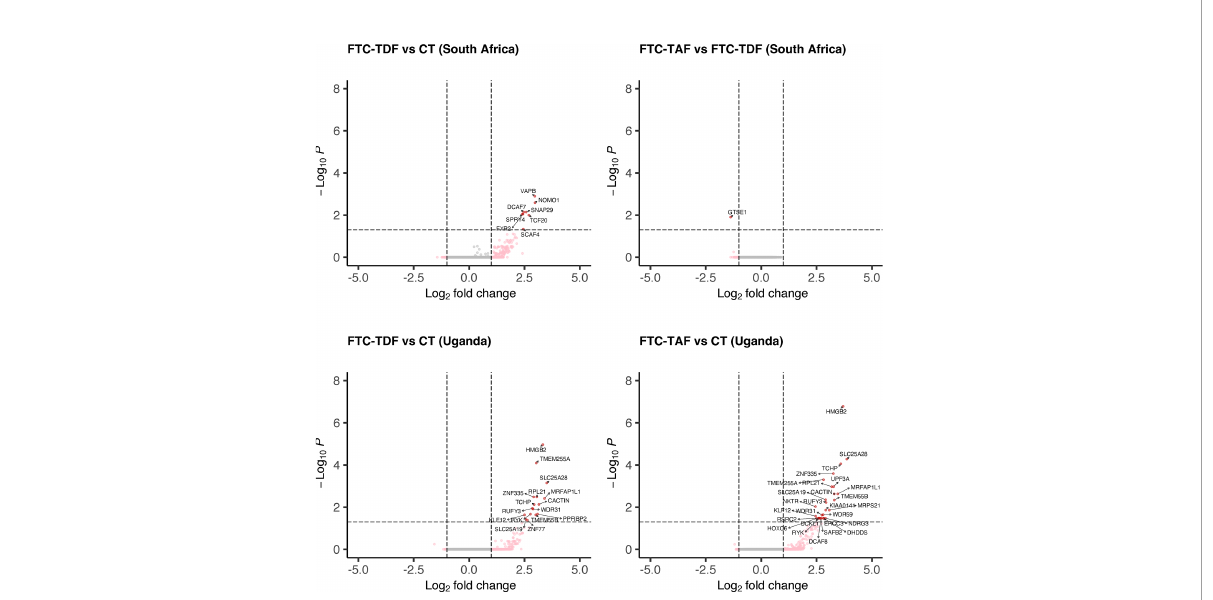
FIGURE 2 Differential gene expression analysis of South African and Ugandan cohorts. Individuals from South Africa and Uganda were strati fi ed according to the type of administered PrEP drug and the expression of transcripts was compared to the corresponding control arm or between drug groups. Only comparisons with statistically signi fi cant (p < 0.05) differentially expressed genes (protein-coding, N=15378) are shown for each